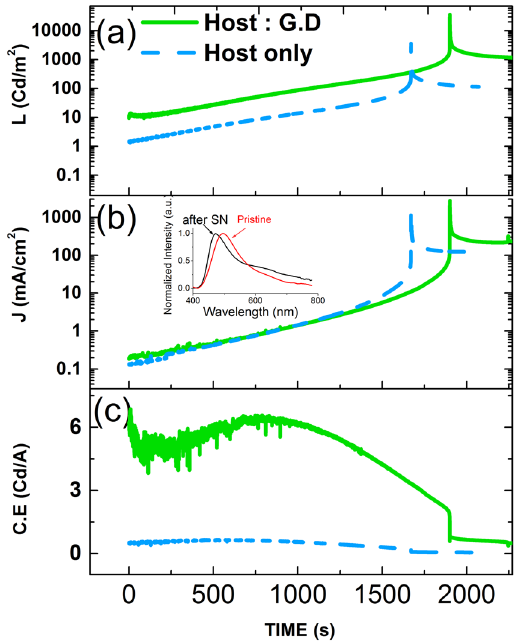
Figure 6. The change of ( a ) luminance, ( b ) current density and ( c ) current efficiency during the burst of luminance. Inset shows the spectrum change before and after the emission